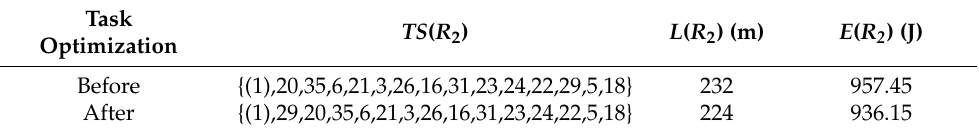
Figure 15. Path planning diagram of Robot 2 after task sequence optimization from Experiment 4. Table 5. The optimal task sequence and operation parameters of Robot 2 from Experiment 4.